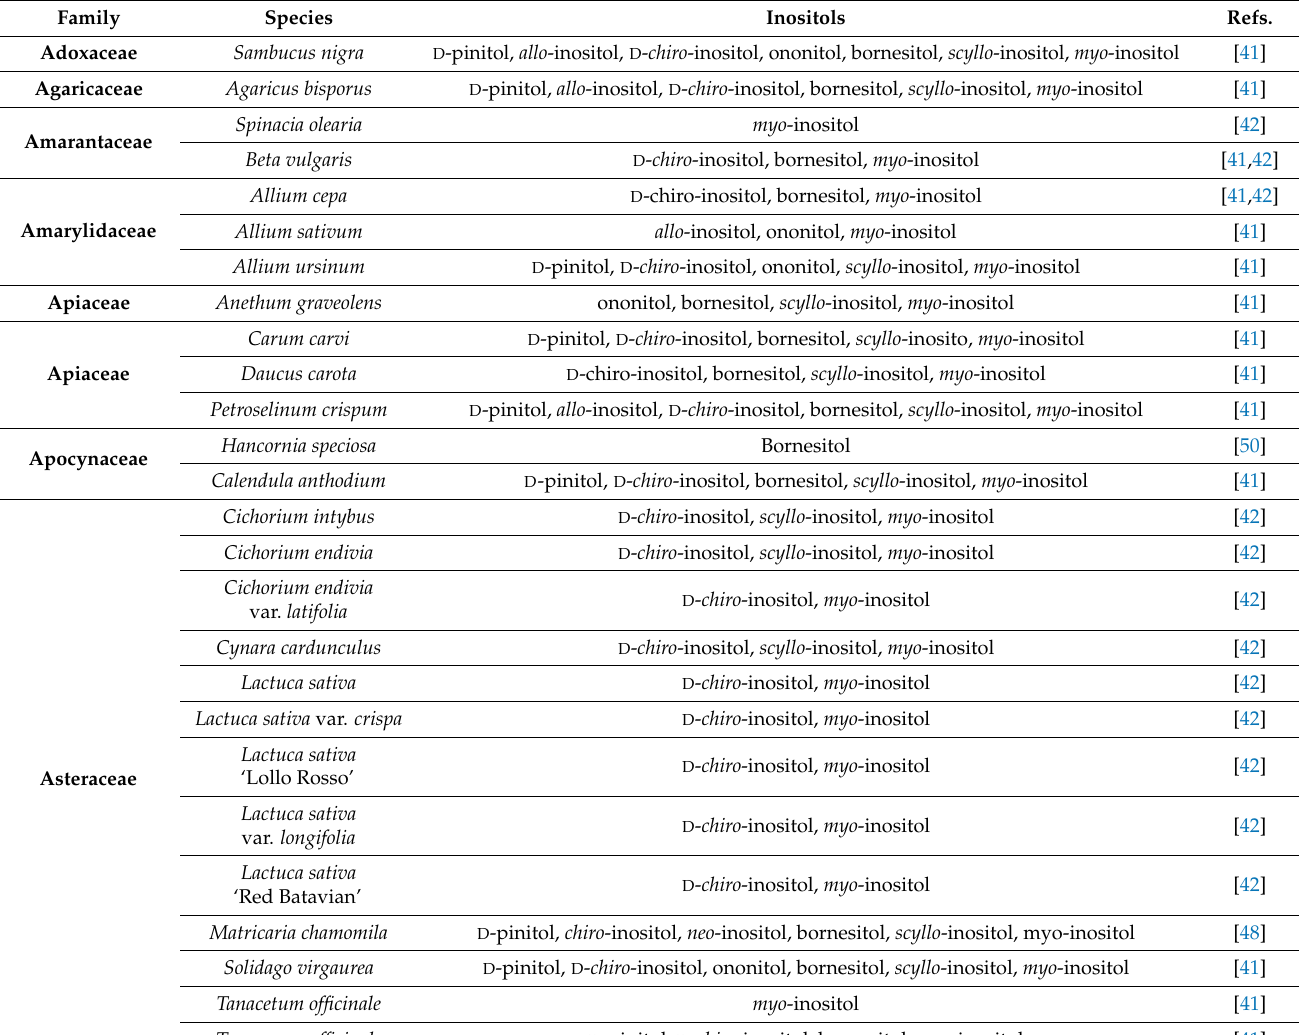
Table 1. Occurrence of inositols in